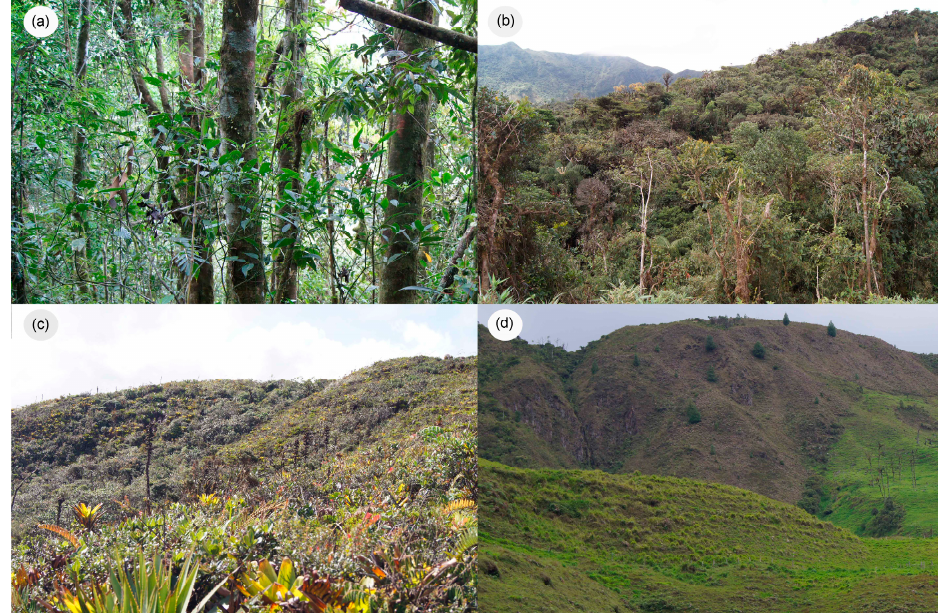
Figure 2. Principal vegetation units in the San Francisco catchment: ( a ) Tropical Mountain Forest (TMF), ( b ) Elfin Forest, ( c ) subpáramo and ( d ) pasture.